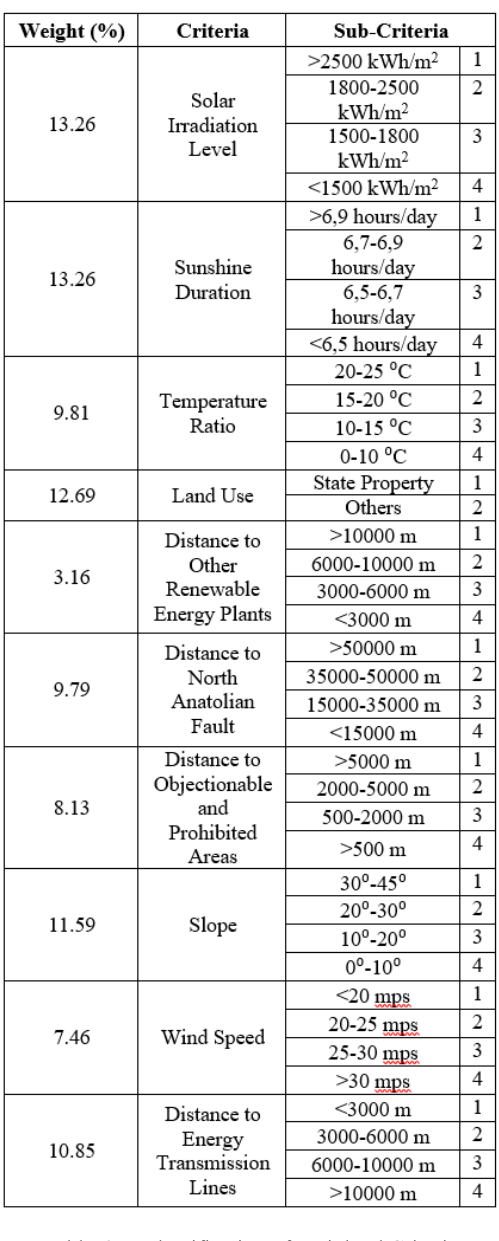
Table 6. Reclassification of Weighted